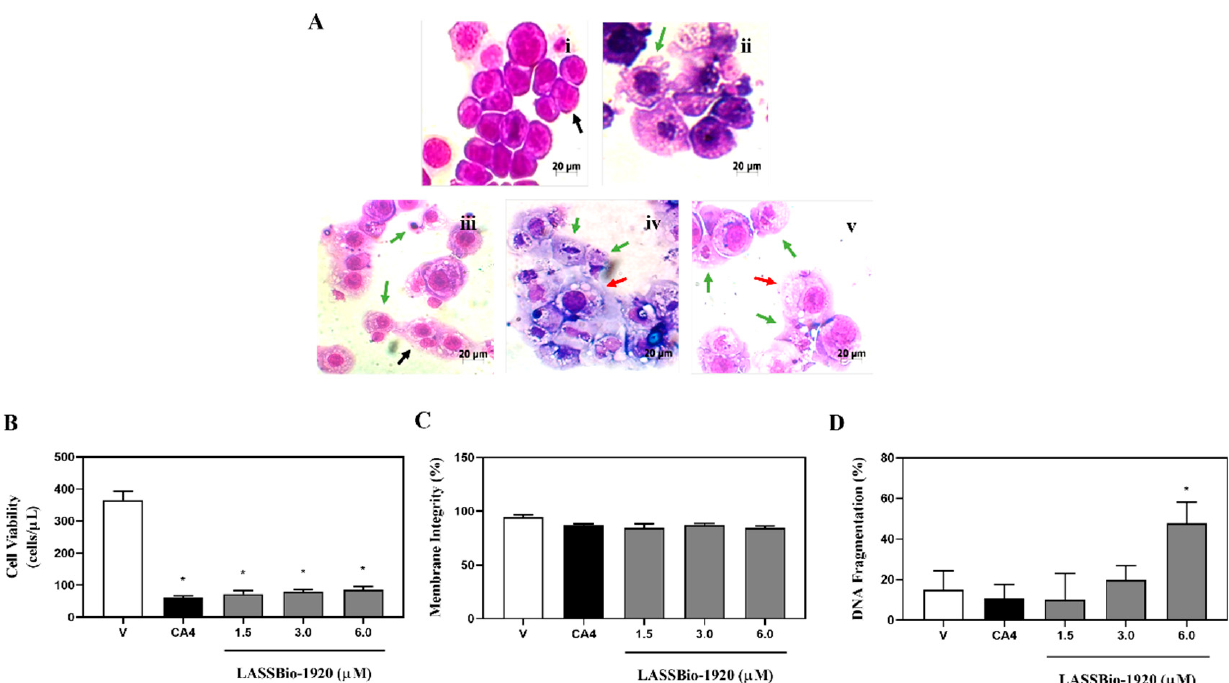
Figure 2. Morphological changes ( A ), cell viability ( B ), membrane integrity ( C ) and DNA fragmen- tation ( D ) of HCT116 human tumor cells treated with LASSBio-1920 (1.5, 3.0 and 6.0 µ M) after 48 h